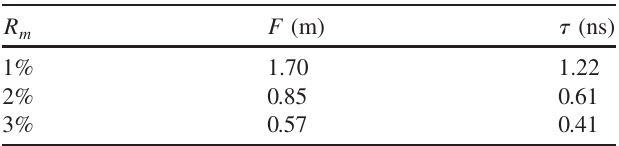
TABLE II. Longitudinal phase width for different ratios of extracted